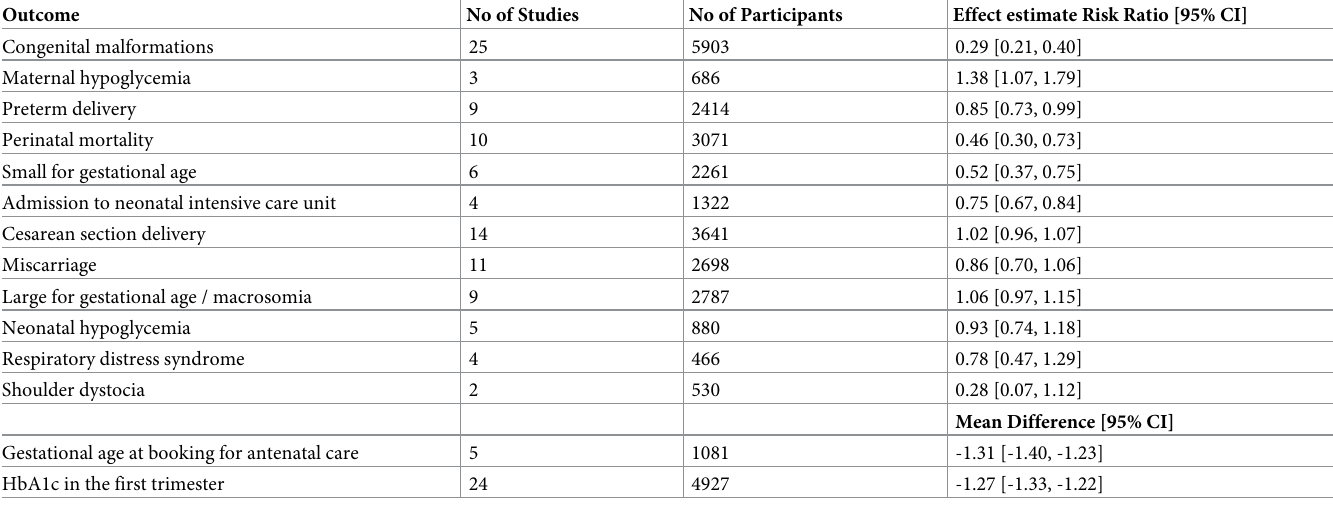
Fig 2. The mean gestational age at the time of the first antenatal visit from five studies of women with pre- existing diabetes mellitus who did or did not receive preconception care. https://doi.org/10.1371/journal.pone.0237571.g002 Congenital malformations . The result of the meta-analysis on the effect of PCC on congeni- tal malformations suggested that PCC resulted in a large reduction in congenital malforma- tions (RR 0.29; 95% CI: 0.21–0.40, 25 studies; 5903 women; high-certainty evidence) (Fig 3) (Table 5). We considered the body of evidence for the effect of PCC on the reduction of con- genital malformations to be high quality mainly due to the large effect size with precise and narrow confidence intervals, consistency of direction of effect throughout most of the included studies, no indirectness of evidence, and no heterogeneity or publication bias. Bias in the included studies was considered moderate (59% of the participants were from studies at low- risk of bias) (Fig 3, Table 6). HbA1c . Meta-analysis of 24 studies which reported HbA1c showed that PCC likely results in a reduction in HbA1c in the first trimester of pregnancy by an average of 1.27%; (MD 1.27; 95% CI: 1.33–1.22; 4927 women; moderate-certainty evidence) (Fig 4) (Tables 5 & 6). We con- sidered bias in the included studies low (77% of the participants were from studies at low risk of bias) (Fig 4, Table 6), while heterogeneity can be explained by long span of time between the Table 5. Pooled estimates effect of preconception